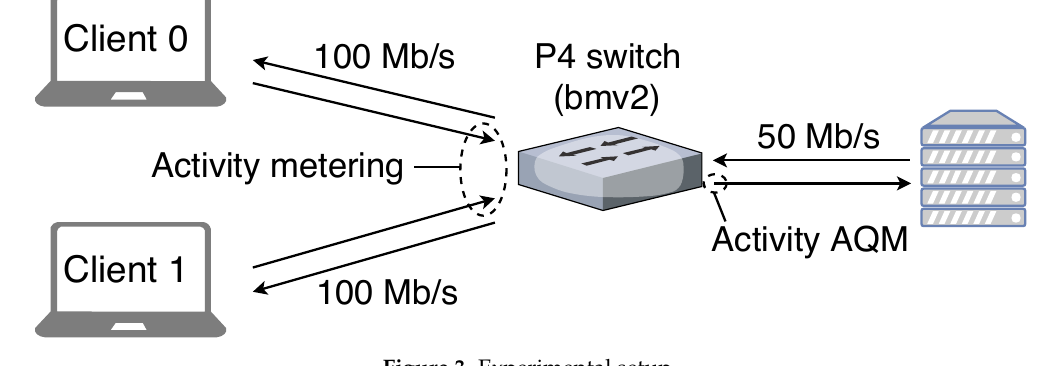
Figure 3. Experimental